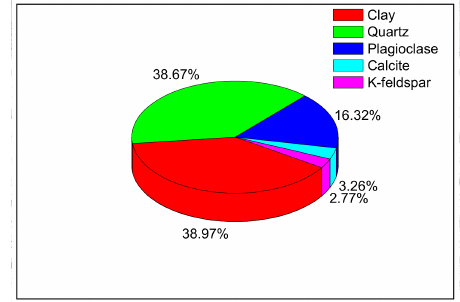
Figure 1. Mineral composition of shale samples